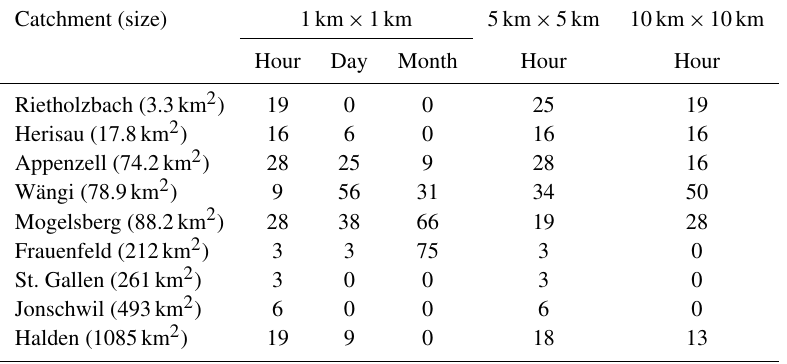
Table 4. Transferability of parameters from the Thur to the nine subbasins, expressed as percentage agreement (%) in detected behavioural runs. The forcing was applied uniformly and the KGE( Q ) was used as an objective